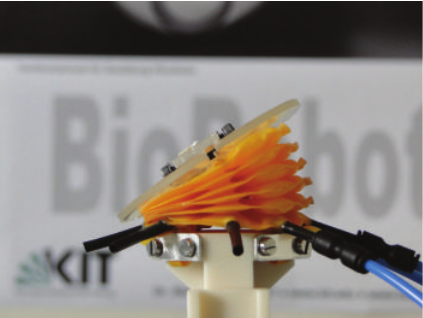
Figure 6: Actuator for internal rotation, 3 chambers with a pressure of 300kPa.